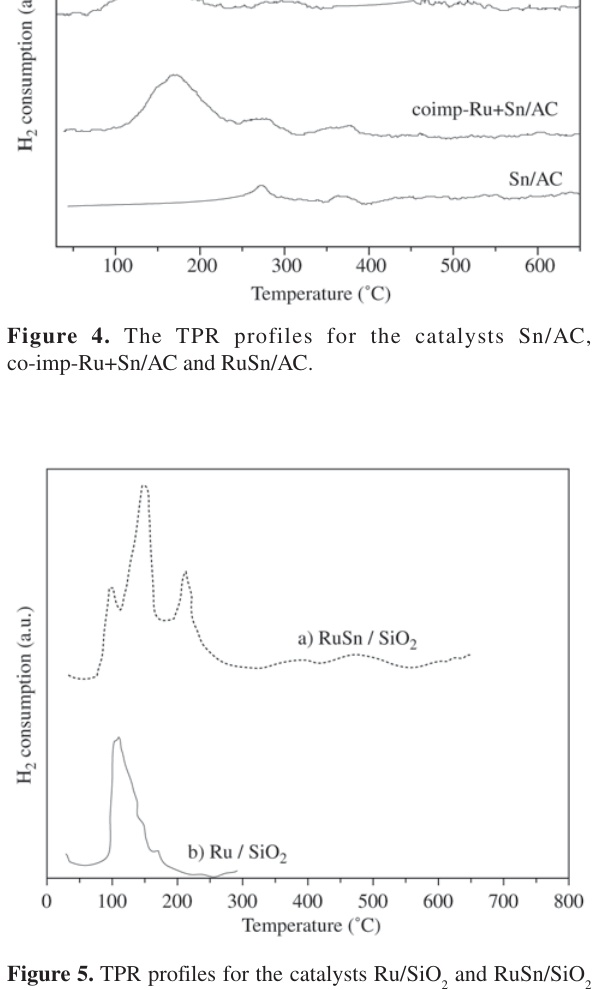
and RuSn/SiO 2 2